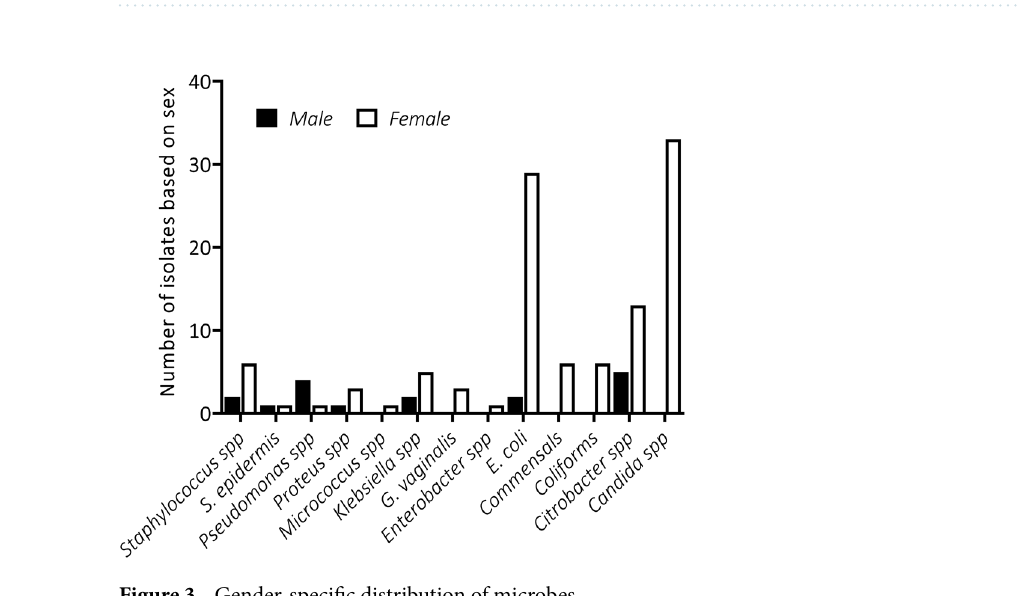
Figure 3. Gender-specific distribution of microbes.